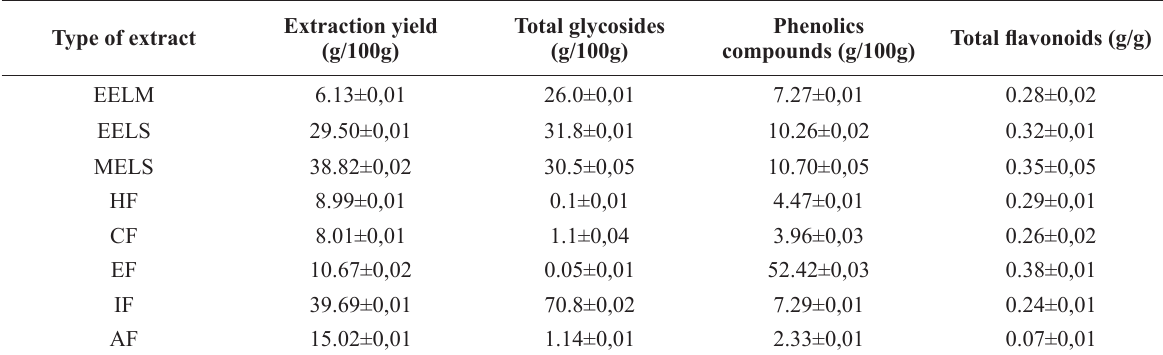
Total compunds present in the Stevia rebaudiana extracts and fractions. Type of extract